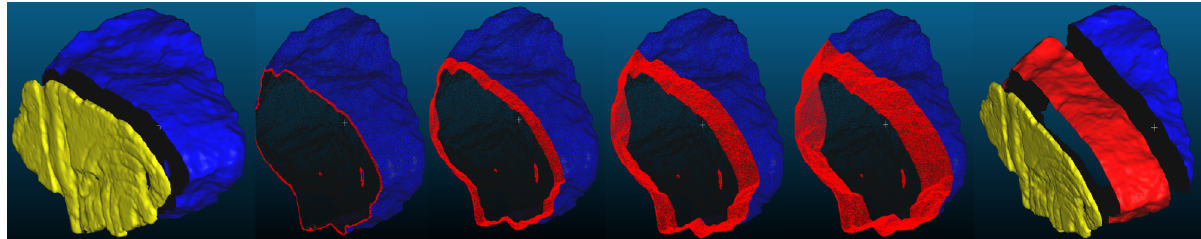
Figure 3: The extreme left models show the extracted plane and its remaining point-cloud marked in yellow and blue respectively. The next five models depict the contour surface point-cloud marked in red, for multiple searching ratios. From left to right, the value of r is, 1 . 0 , 5 . 0 , 10 . 0 , and 20 . 0 .